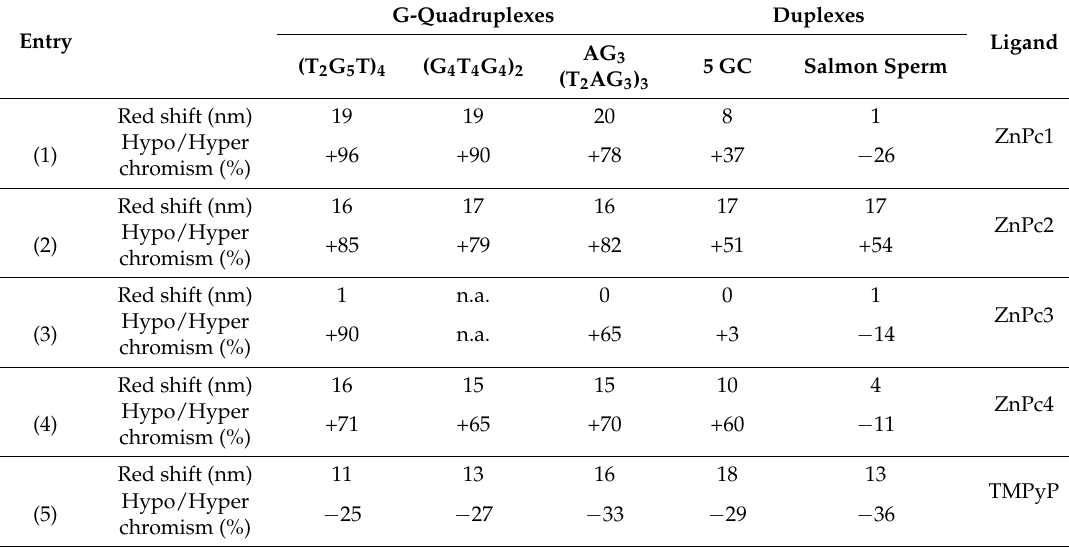
Table 2. Red shifts and hypochromic/hyperchromic percentages observed when ligands were titrated with the different DNA